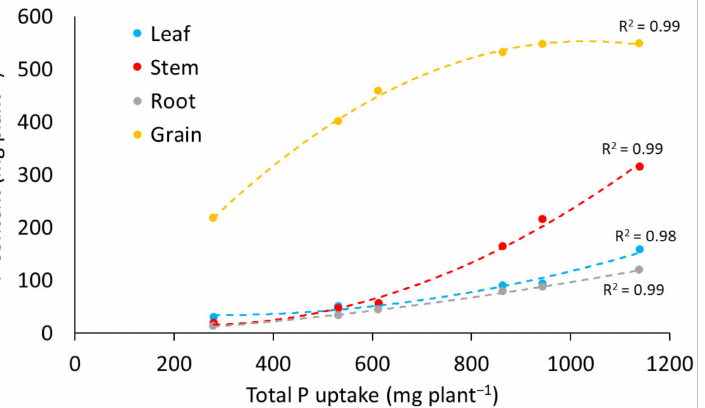
Figure 4. Phosphorus (P) partitioning into leaf, stem, root, and grain. “Stem” includes stem, cob, and tassel, and “Leaf” includes leaves and husk. Values averaged for each P treatment across